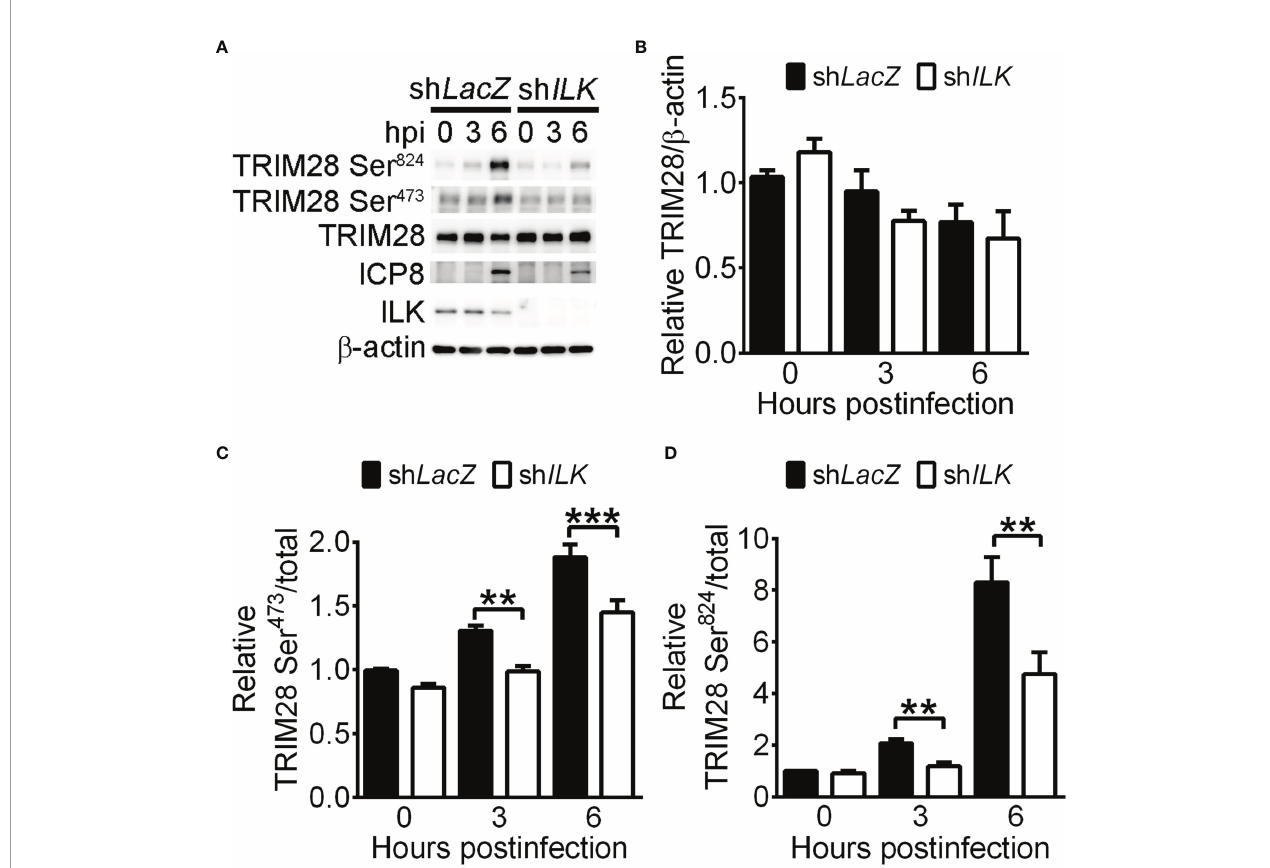
FIGURE 6 | ILK facilitates TRIM28 phosphorylation on serine 473 and 824 in HSV-1-infected cells. The representative western blots of indicated proteins (A) and quantitative results (B – D) of indicated proteins in control (sh LacZ ) and ILK (sh ILK ) knockdown cells infected with HSV-1 at indicated hours postinfection are shown. The levels of TRIM28 to b -actin and phosphorylated TRIM28 to total TRIM28 in control cells at 0 hours postinfection were set as 1. Data represent mean + SEM (error bar). ** p < 0.01, *** p < 0.001 via Student t